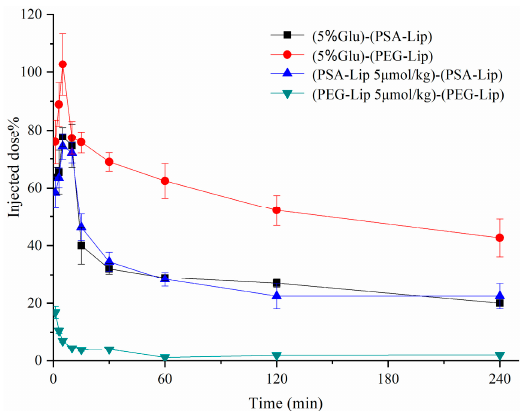
Figure 5. Pharmacokinetic profile (0–4 h) in beagle dogs after intravenous single and repeated injections of DiR labeled liposomes. Data were shown as mean ± S.D., n = 3.